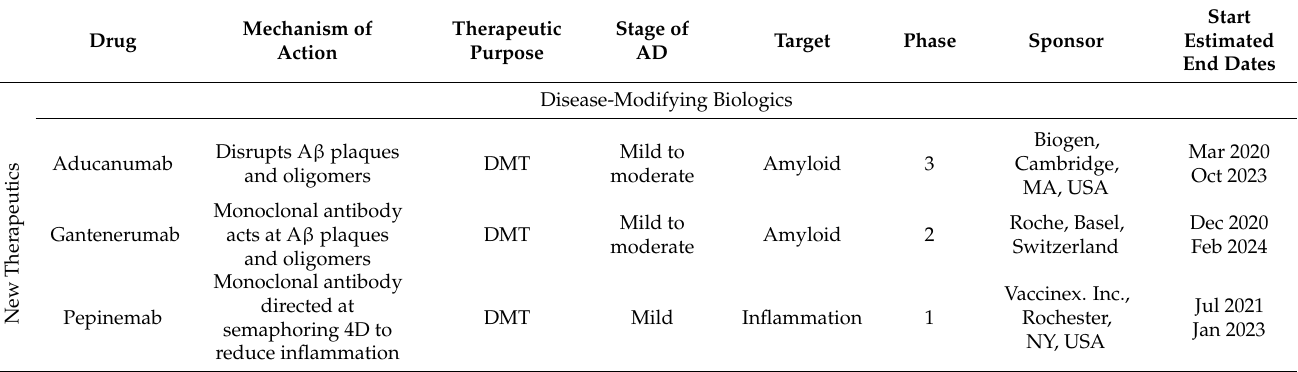
Table 2. Promising candidates in pipeline to treat